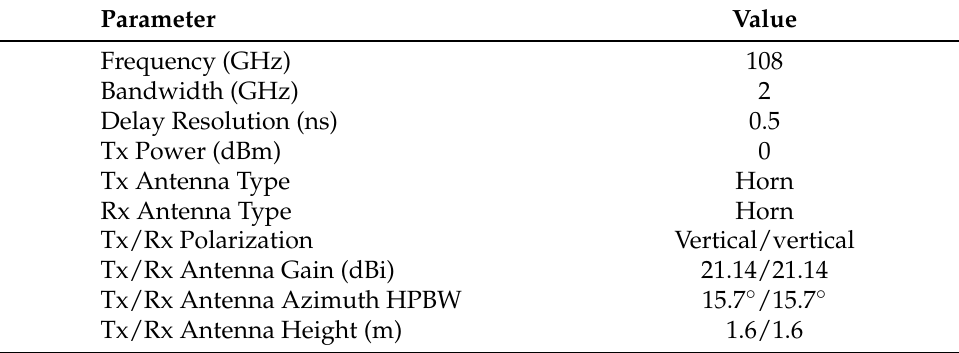
Figure 4. Measurement setup in the Manufacturing laboratory (MANULAB)at the Norwegian University of Science and Technology (NTNU). It contains many pieces of medium size equipment. Table 3. Measurement setup parameters. HPBW, half power